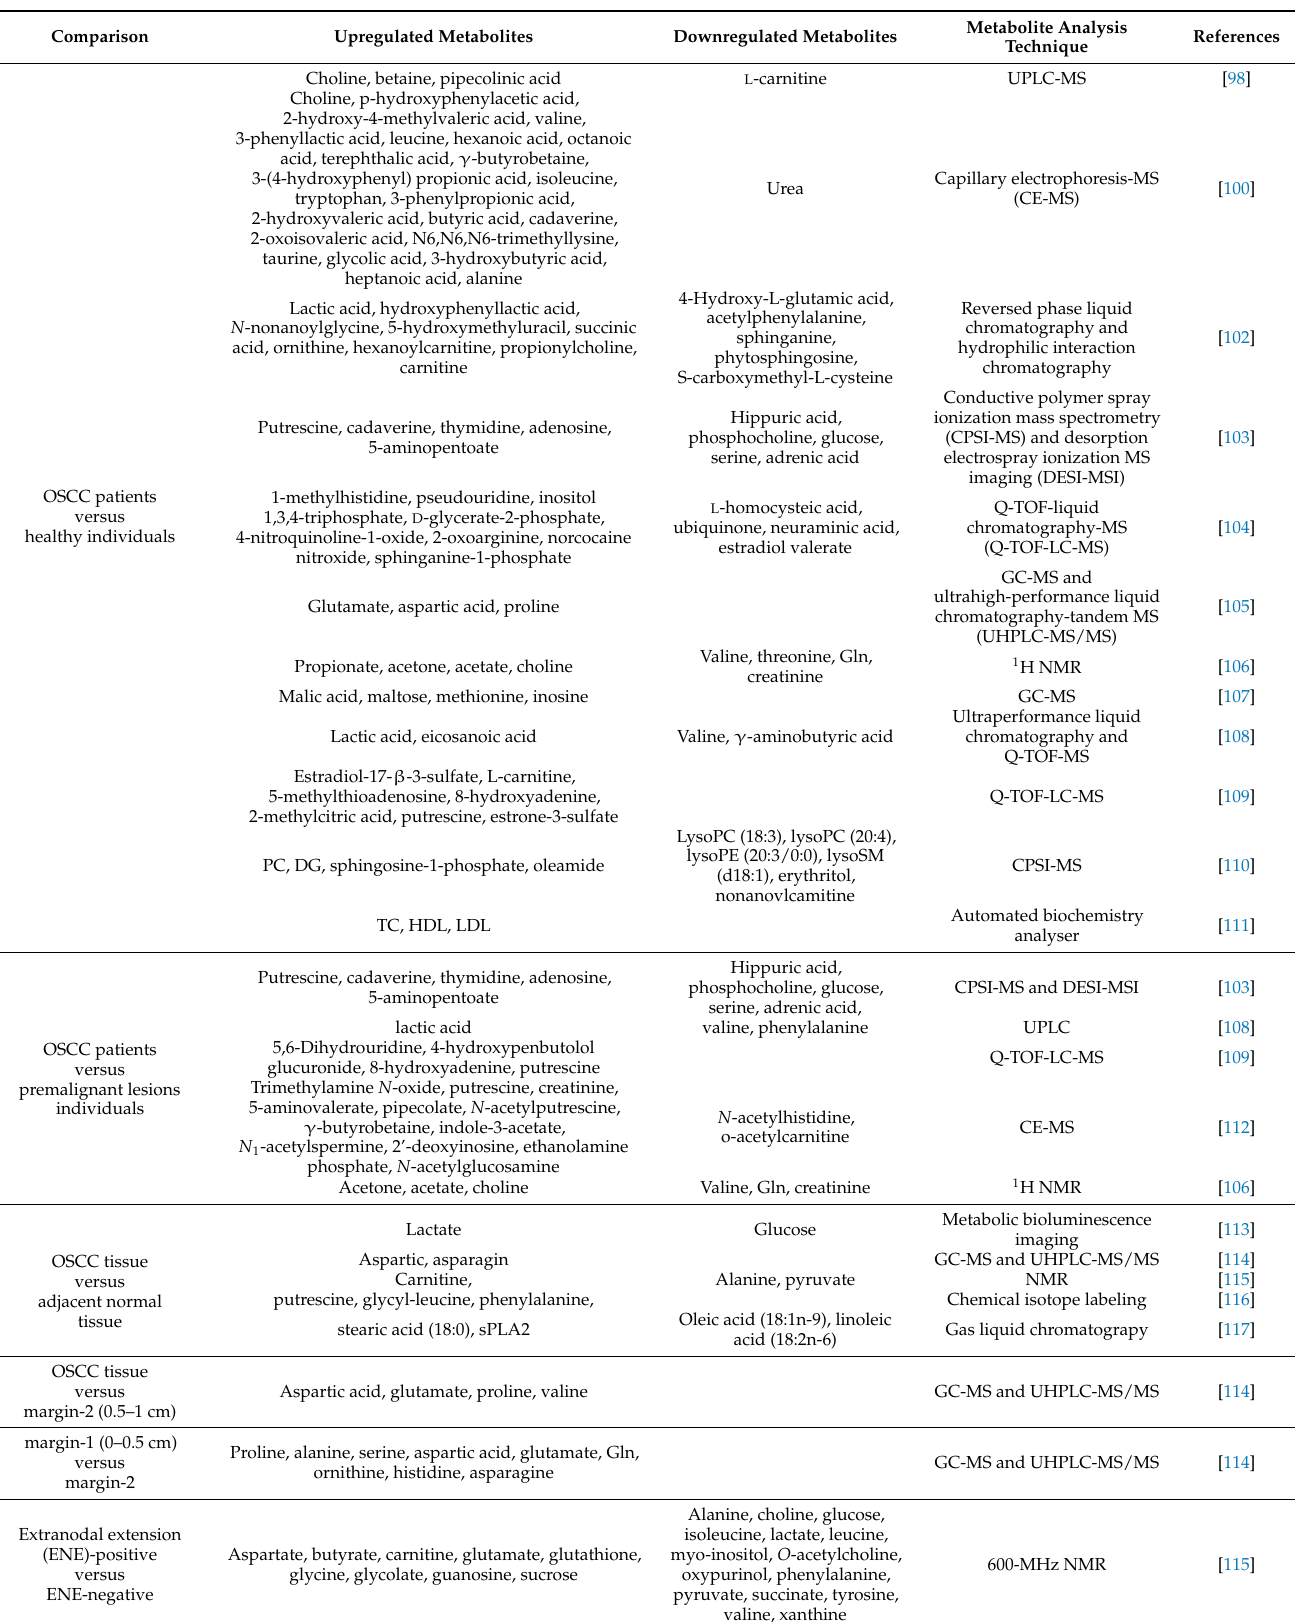
Table 1. Metabolites in